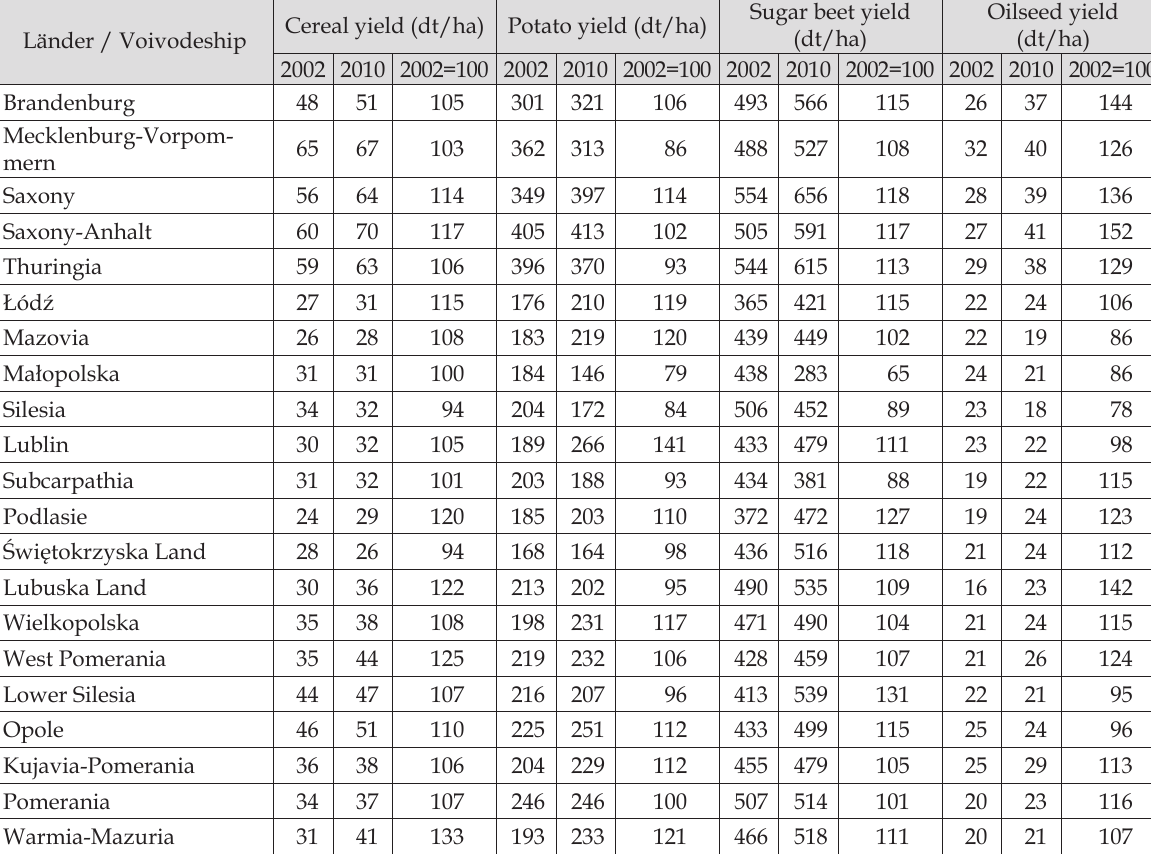
Table 2. Dynamics of change in the yields of the main crops in Poland and East Germany länder /